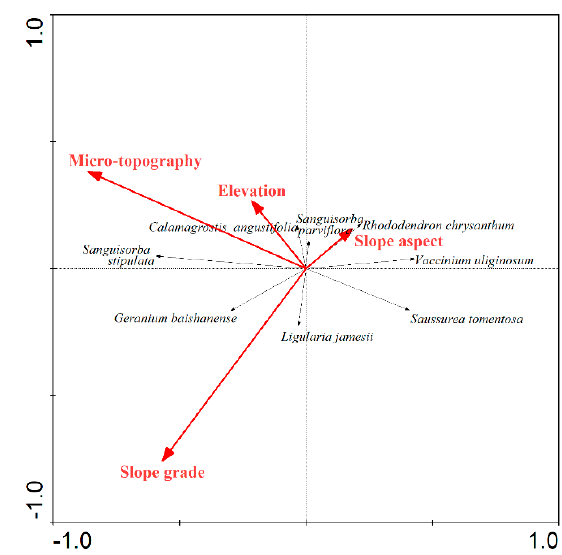
Figure 4. The abundance of the eight dominant species in relation to micro-topography. Note: Rc, indicate R. chrysanthum . Sp, S. parviflora . Ss, S. stipulata . Lj, L. jamesii . Ca, C. angustifolia . Gb,